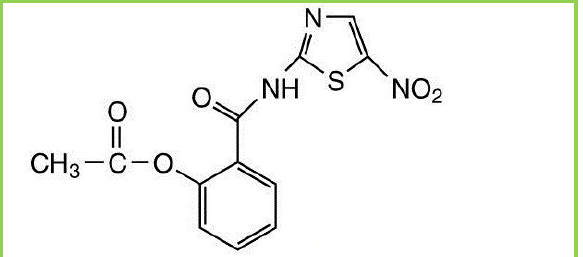
Figure 2. Chemical structure of